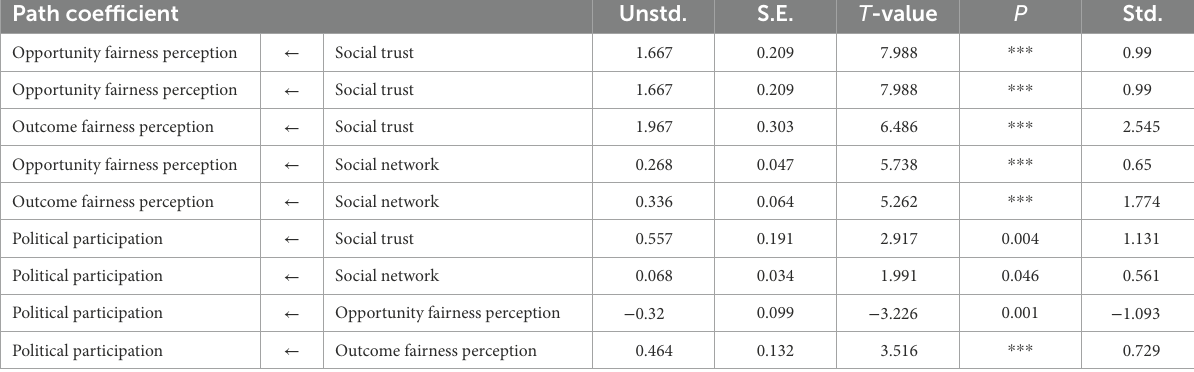
TABLE 4 Structural path test